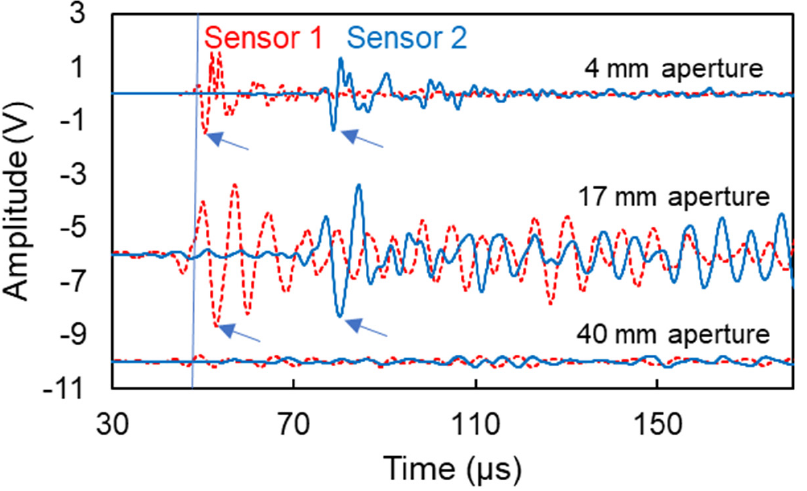
Figure 10. Typical surface waveforms collected by two sensors for different apertures. The arrows identify characteristic Rayleigh points used for velocity calculations. The vertical axis has been offset for the different apertures for clarity, while the amplitude of the waveforms has not been altered. Based on a characteristic Rayleigh point (e.g., negative peak as indicated by the arrows in Figure 10), the Rayleigh wave velocity is calculated at 2402 m/s using the small sensors and 2173 m/s using the medium sensors, while it was not straightforward to identify such points for the large